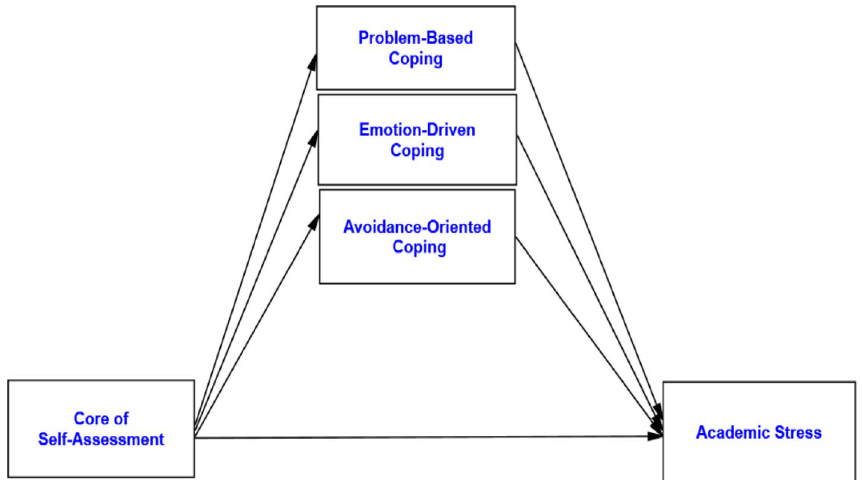
Fig. 1 Research model of the present